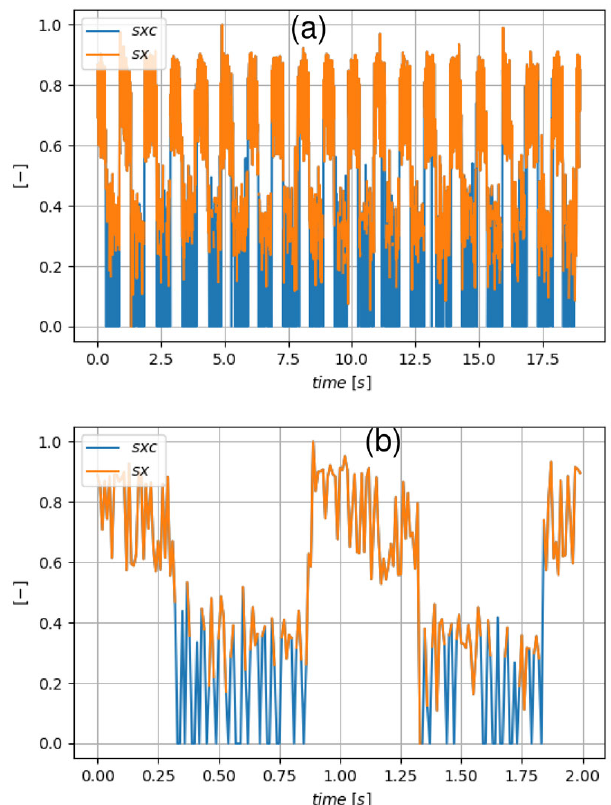
Figure 5. Streamwise coordinate of the identified strip sx before correction and sxc after correction: (a) the full run and (b) a zoom on the two first oscillations.